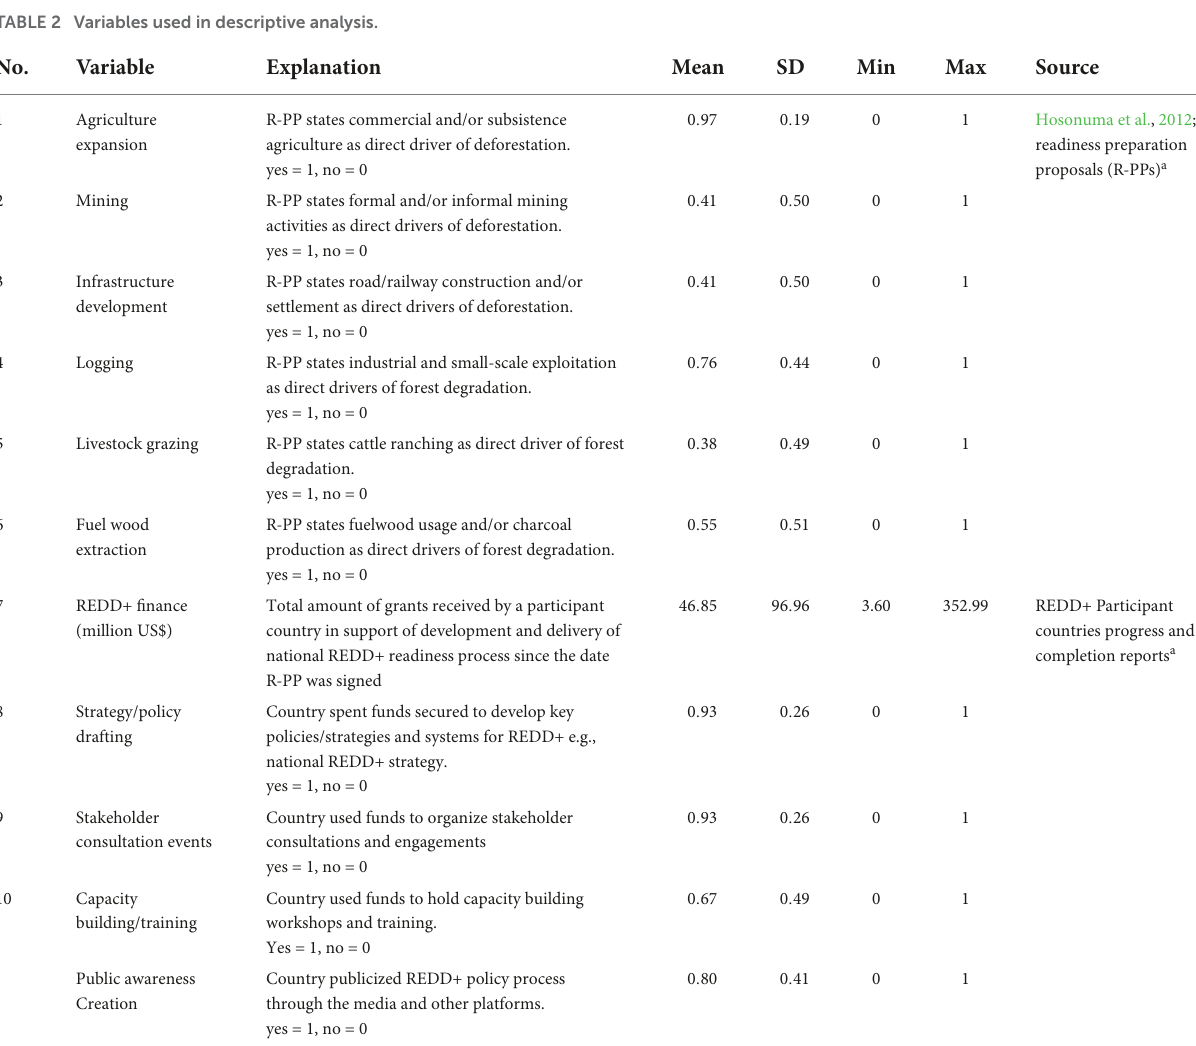
TABLE 2 Variables used in descriptive